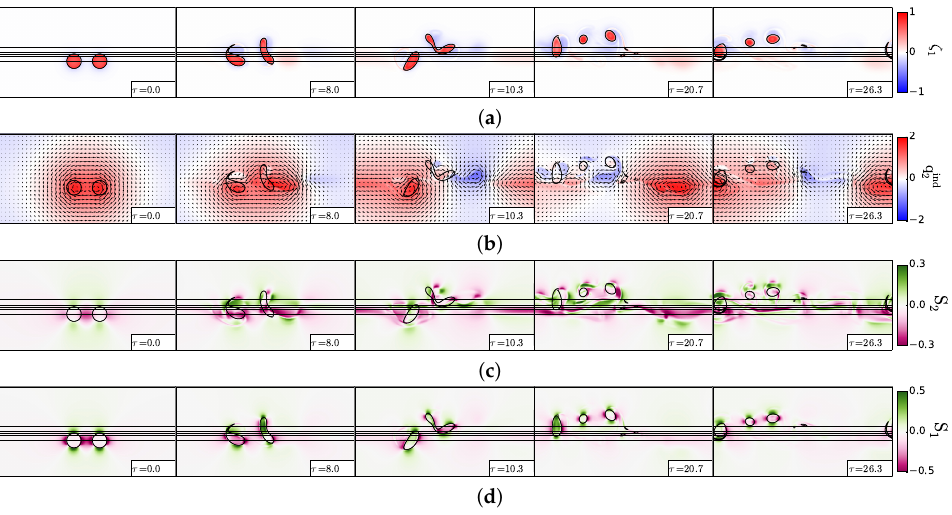
Figure 14. Drift and splitting of two cyclones, case d / R = 3.6, γ R = 2, d c / R = 1. ( a ) Upper layer relative vorticity (Equation (3)); ( b ) lower layer “equivalent barotropic” potential vorticity and velocity field (Equations (4) and (11)); ( c ) lower layer velocity shear (Equation (5)); ( d ) upper layer velocity shear (Equation (5)). In (a,c,d), the black contours indicate the topographic slope (Equation (12); straight lines) and the upper layer vorticity contours showing the two vortex evolution.